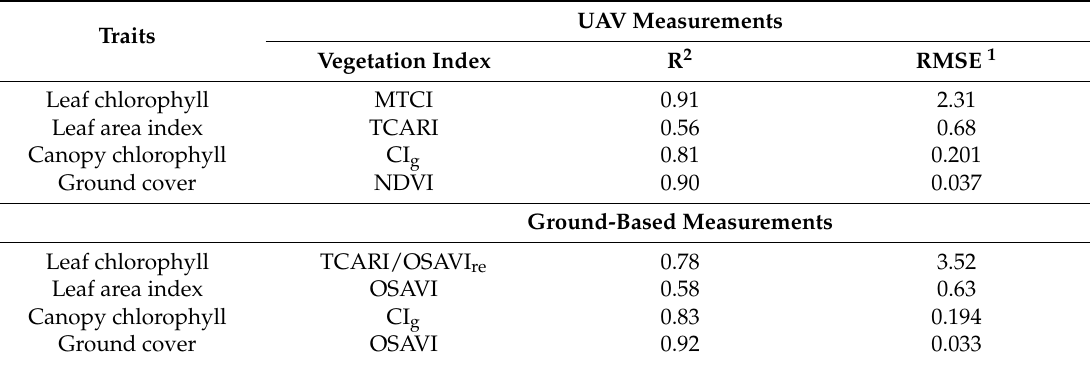
Table 4. Coefficient of determination and RMSE (from repeated 10-fold cross-validation) for linear regressions between crop traits and vegetation indices calculated from UAV and ground-based data acquired on the last 4 acquisition dates (from 62 to 99 DAP). Only indices with the best prediction performance for both datasets are presented (the complete results are shown in the Table A1). UAV Measurements Traits Vegetation Index R 2 RMSE 1